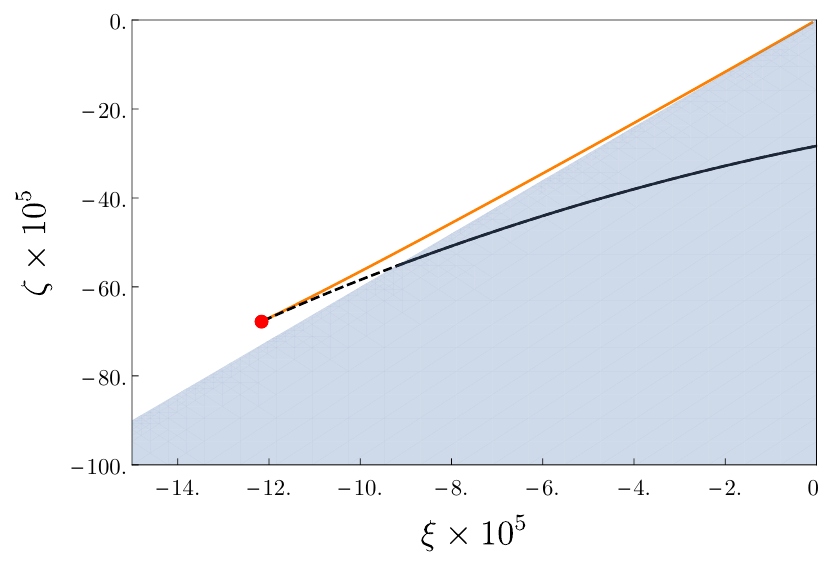
Figure 11 . A breakdown of the coupling parameter space into useful regions for bolt solutions. Here the orange and black curves denote lines of ‘critical points’, i.e., for a given NUT charge, three solutions for r b coalesce. The red dot represents the single point in the physical parameter space where there is a coalescence of four roots. Within the blue shaded region, (cid:16) < 6 (cid:24) and there are bolts for arbitrarily large n . In the complement, (cid:16) > 6 (cid:24) and there is a largest value of n for which bolts exist. On the black locus of critical points, the critical point is always physical (i.e. of lowest free energy) within the blue region, otherwise (for the dashed portion of the curve) the situation can depend on which branch of the cusp minimizes the free energy, and also on whether or not there are re-entrant phase transitions as described in the